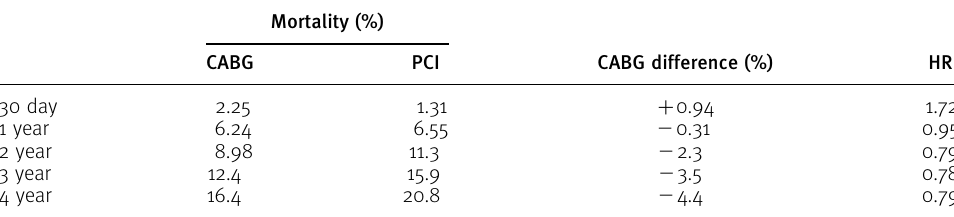
Table 3. Mortality with CABG and PCI at 4 years in ASCERT trial (Reference 12) Mortality (%)